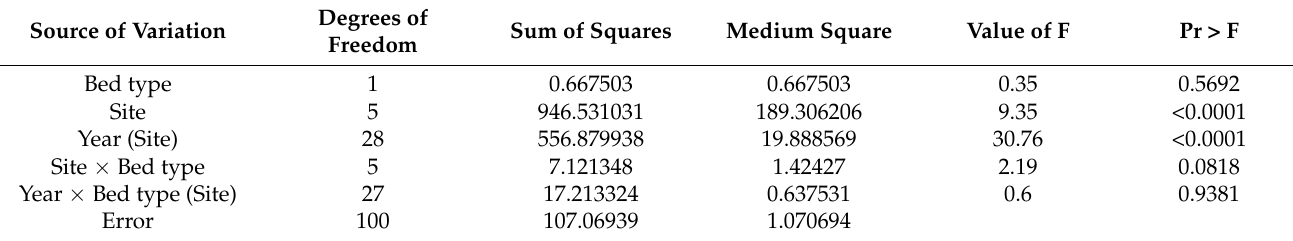
Table 4. Combined variance analysis of the maize yield in two bed types, under rainfed conditions.